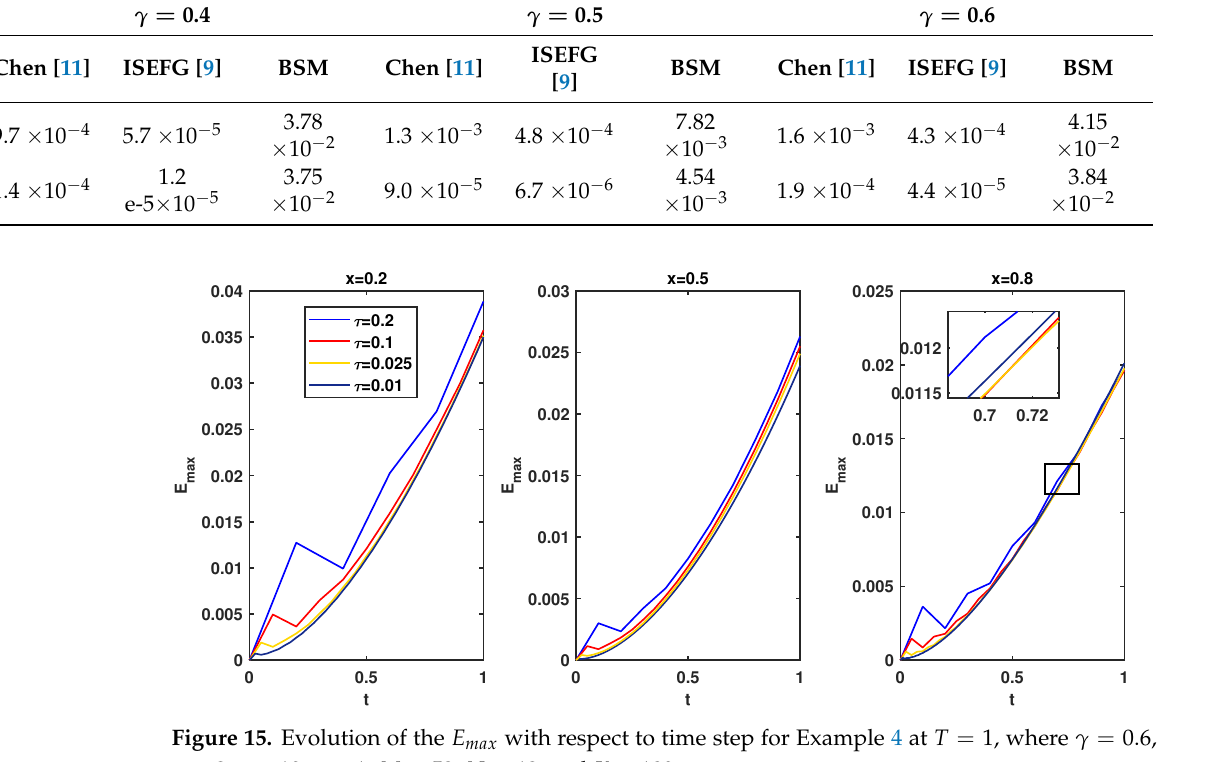
Figure 15. Evolution of the E max with respect to time step for Example 4 at T = 1, where γ = 0.6, α = 2, c = 10, ν = 1, M = 52, N = 12, and K =